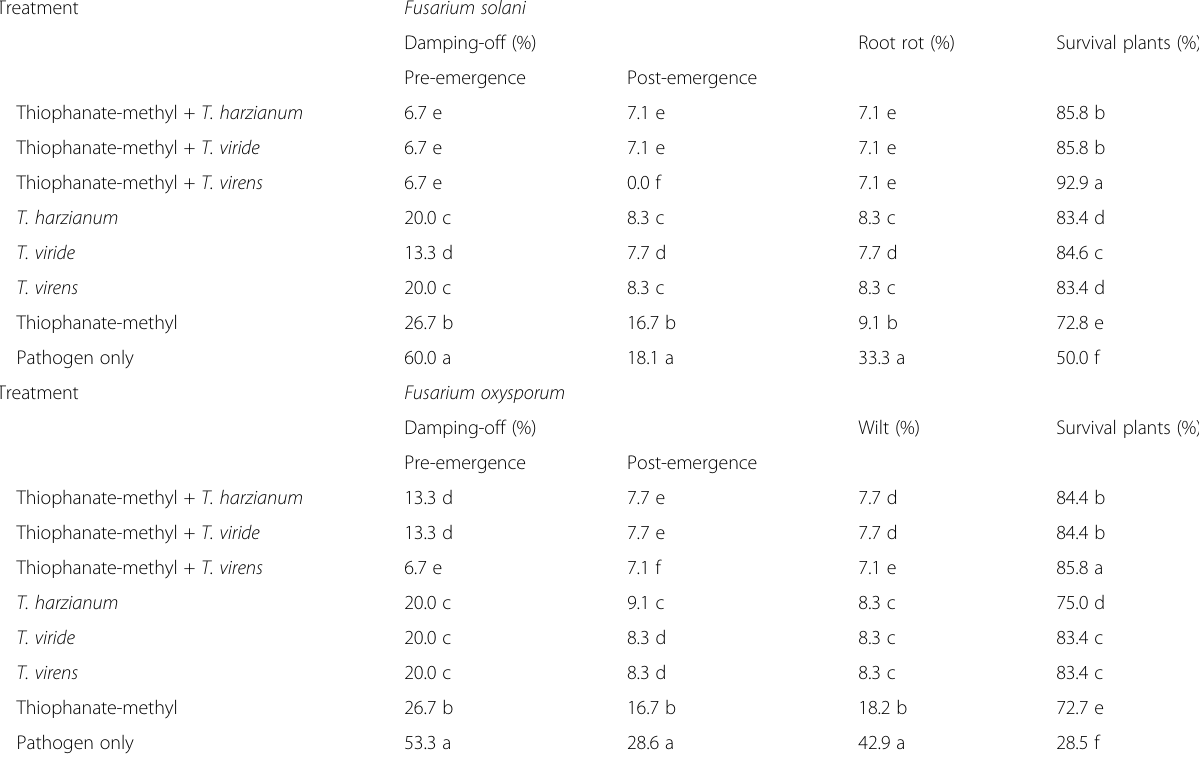
Table 1 Effect of soil application with Trichoderma spp. and seed coating with thiophanate-methyl employed either alone or in combination on damping-off, root rot/wilt, and survival dry bean plants grown in soil artificially infested with each of Fusarium solani and Fusarium oxysporum under greenhouse conditions